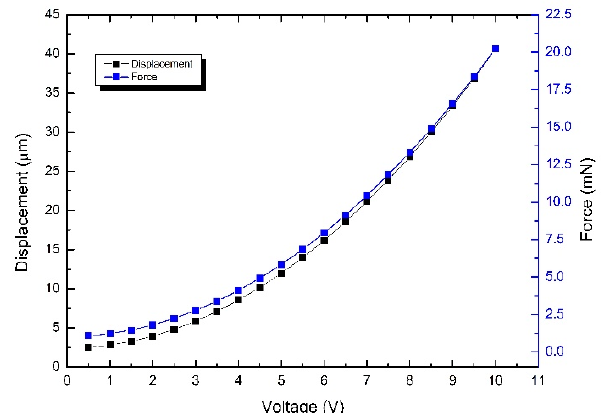
Figure 9. Voltage vs. displacement and force at a jaw of initial microgripper.